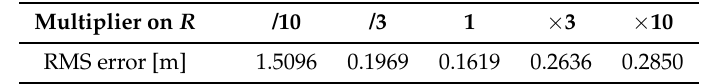
Table 2. Indication that the latency compensated VIO is well-tuned for EuRoC V1 medium dataset.